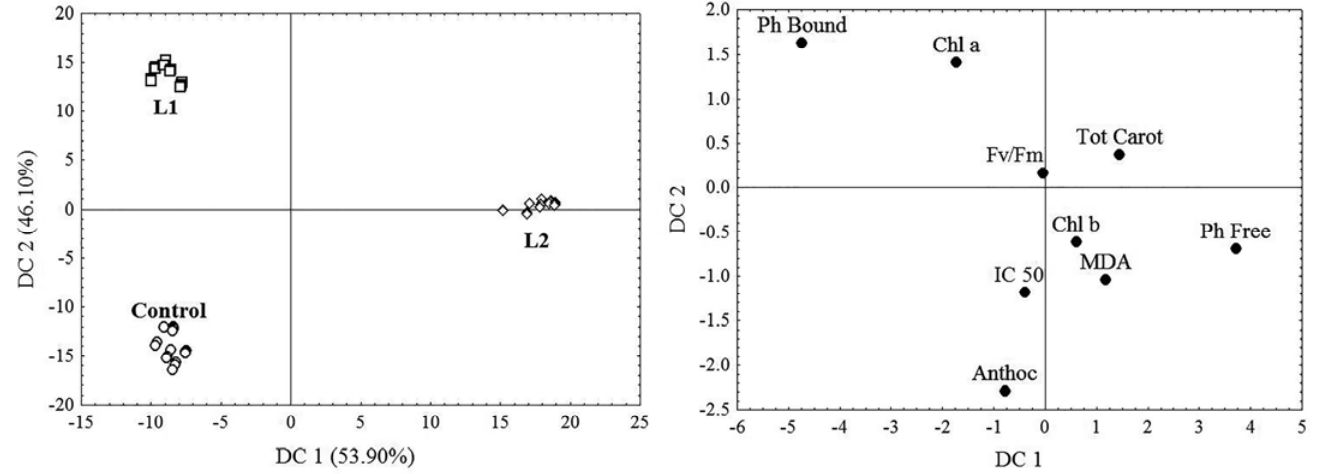
Figure 4. Canonical discriminant analysis (CDA) based on the biochemical response of the leaves of T. tetrandra on fly ash (L1 and L2) and soil (Control). Table 5. Spearman’s correlations between physiological and biochemical parameters and heavy metal(loid) concentrations in T. tetrandra leaves